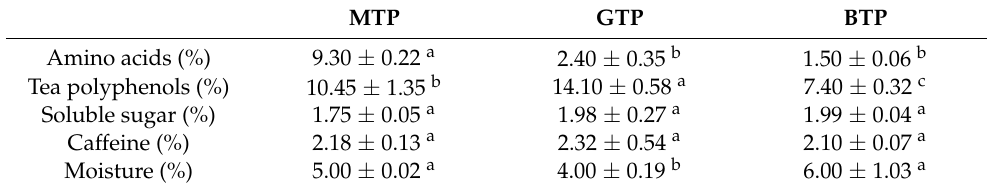
Table 1. Chemical analysis of MTP, BTP, and GTP.